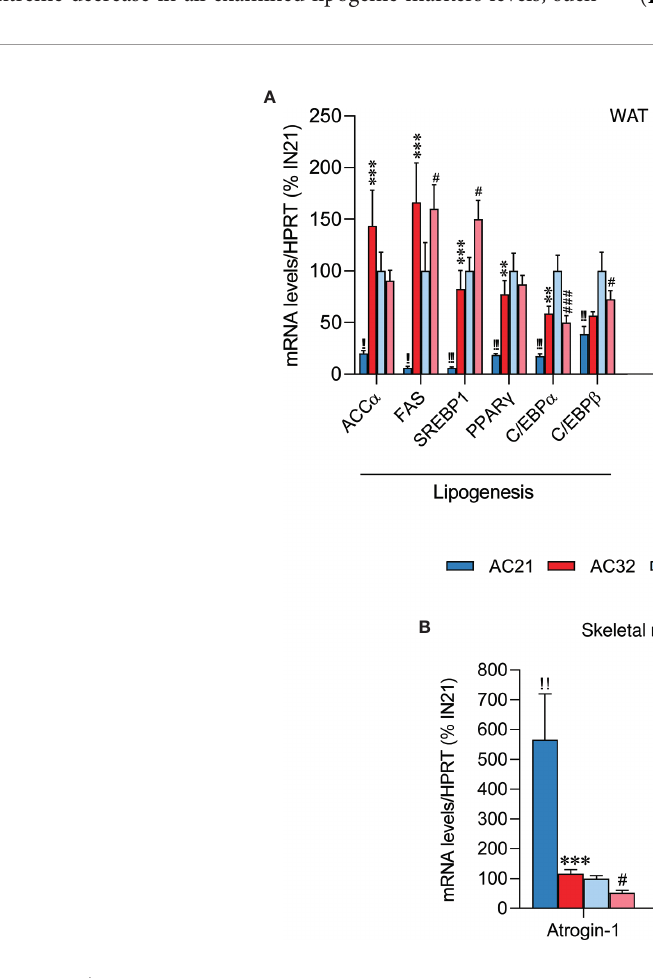
FIGURE 2 | Effect of ABA and temperature on WAT and muscle. mRNA levels of (A) lipogenesis and lipolysis markers in the WAT (n = 8-11 rats/group) and (B) cachexia markers in skeletal muscle (n = 8-11 rats/group) of active rats at 21°C and 32°C (AC21 and AC32) and inactive rats at 21°C and 32°C (IN21 and IN32). *P < 0.05, **P < 0.01, ***P < 0.001 vs . AC21; # P < 0.05, ## P < 0.01, ### P < 0.001 vs. IN21; !! P < 0.01, !!! P < 0.001 IN21 vs. AC21. Data expressed as mean ±